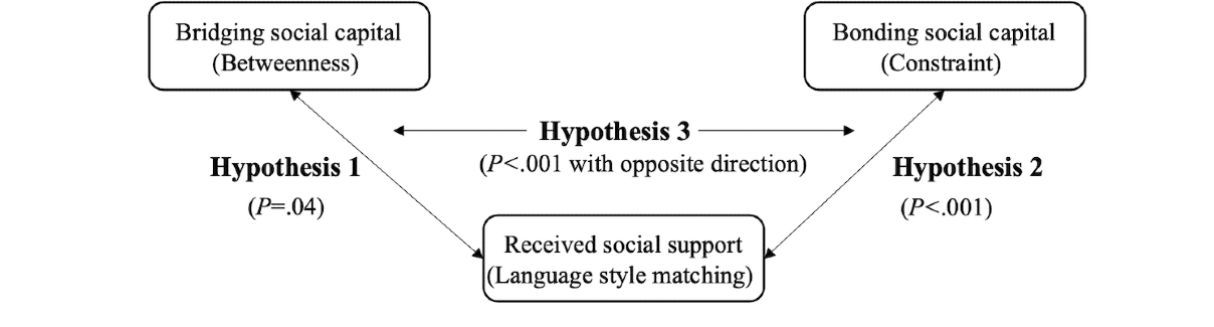
Figure 4. Theoretical framework and results for Hypothesis 1, Hypothesis 2, and Hypothesis 3.